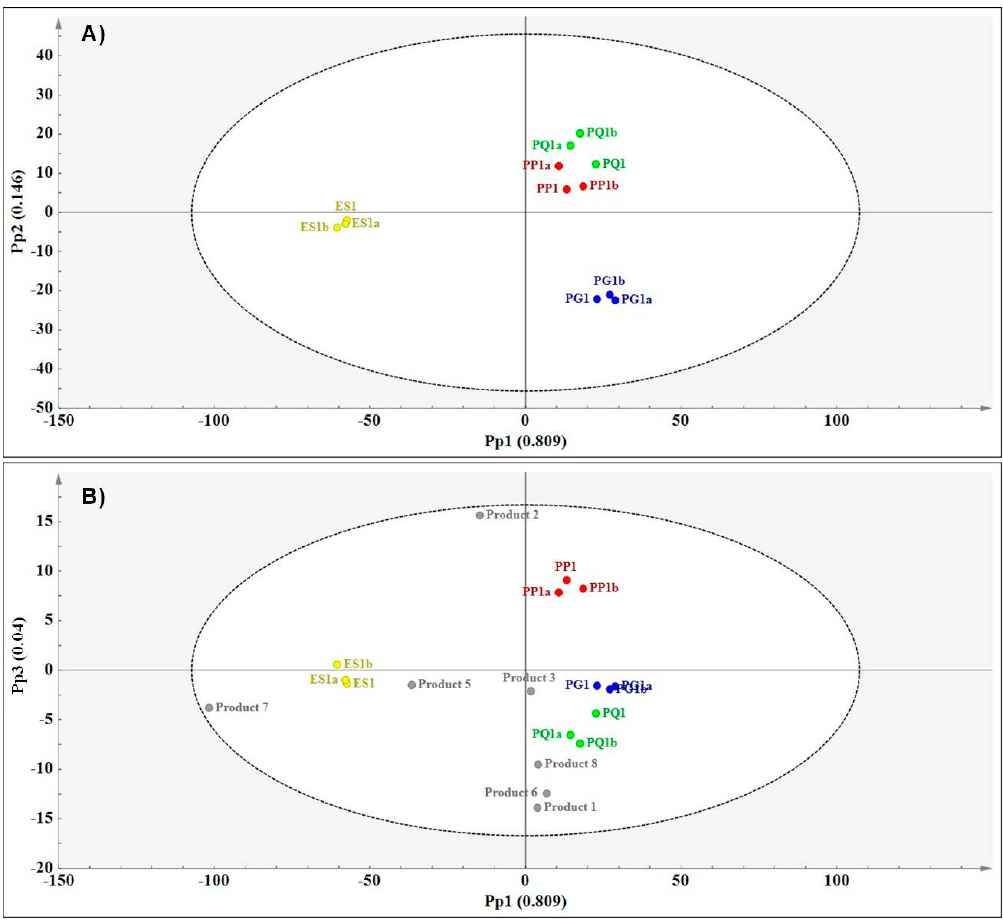
Figure 6. ( A ) OPLS-DA score plot (Pp1 vs. Pp2) showing species separation (PG— P. ginseng (blue); PG— P. quinquefolius (green); PP— P. pseudoginseng (red) and ES— E. senticosus (yellow) and ( B ) prediction plot (Pp1 vs. Pp3) showing the relationships between the authentic reference materials and the commercial products based on NIR